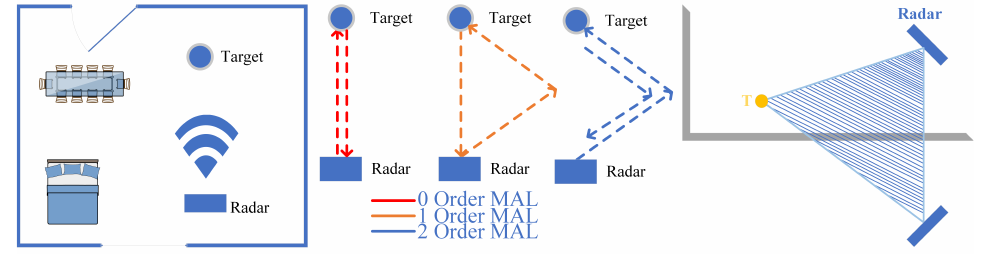
Figure 4. Multipath effect.